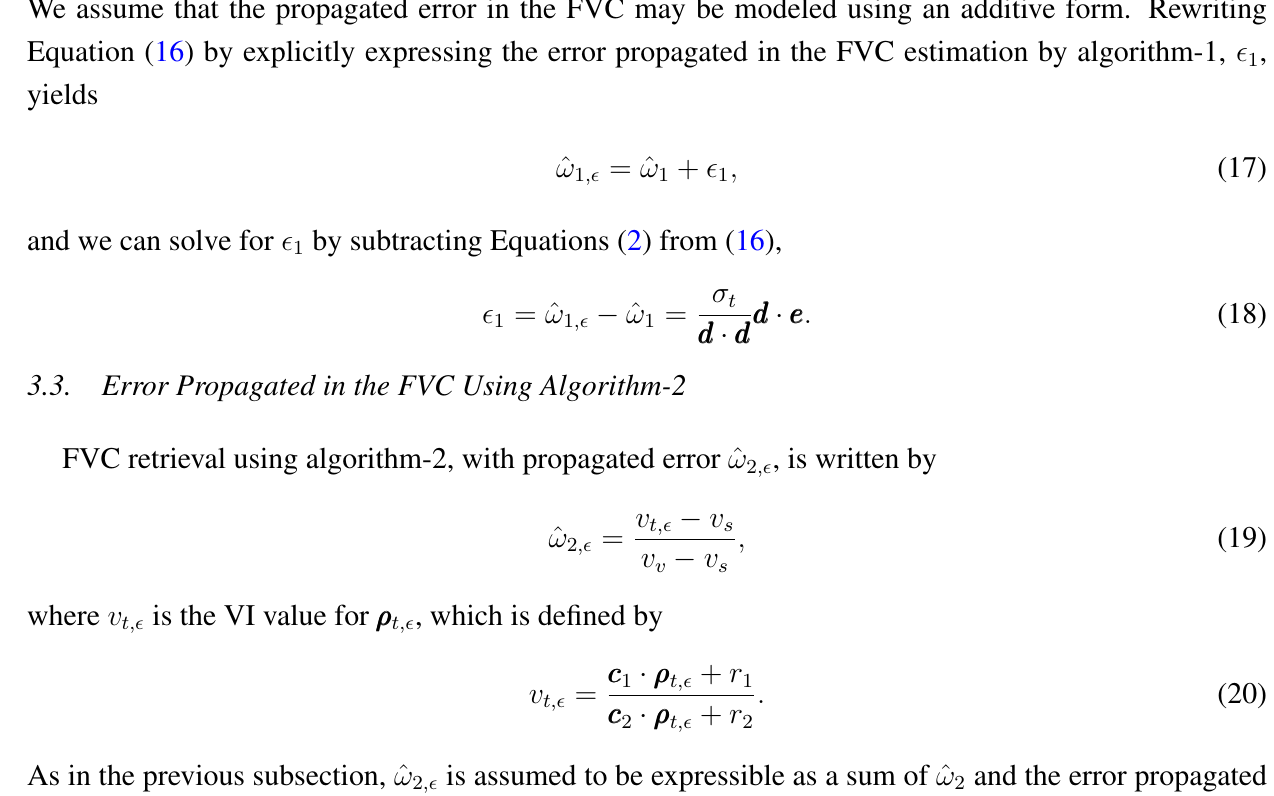
Figure 2 . Illustration of the noise added to an assumed target spectrum, used to derive the noise propagation function. The input noise is modeled as band-correlated additive noise. The angular parameter θ determines the direction of the band-correlation eee . The magnitude of the additive noise is represented by a parameter σ , which is equivalent to the standard t deviation of the two-parameter normal distribution describing the band-uncorrelated noise.